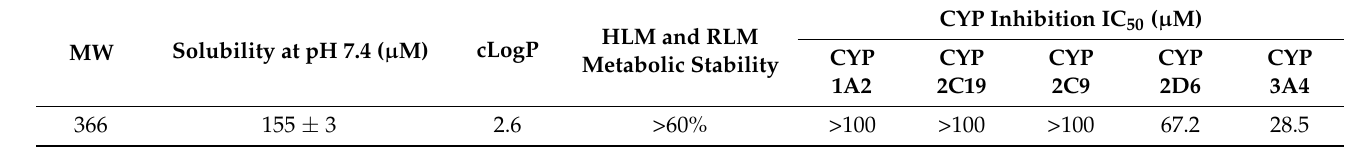
Table 6. ADMET properties of